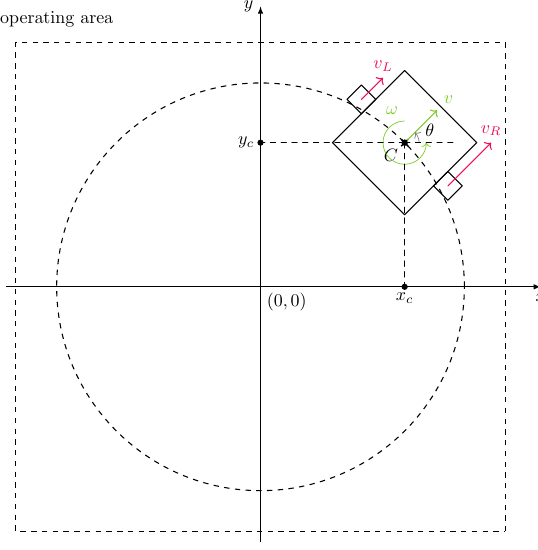
Figure 1. The mobile robot with the input and state